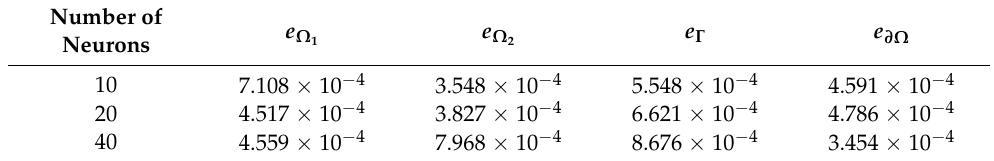
Table 4. Comparison of errors in different terms with different numbers of neurons for Example